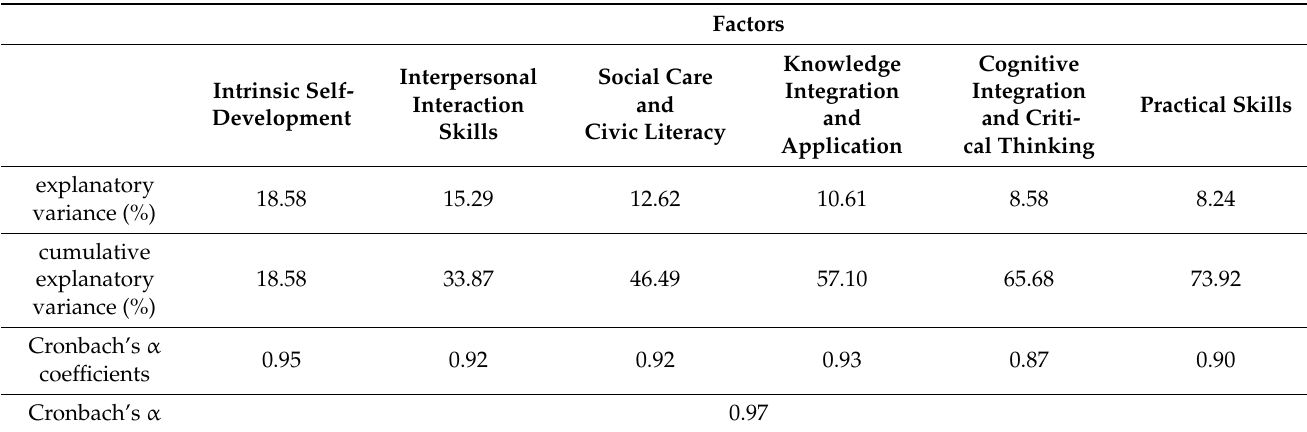
Table 2. Factor Analysis Summary of Learning Outcomes in College